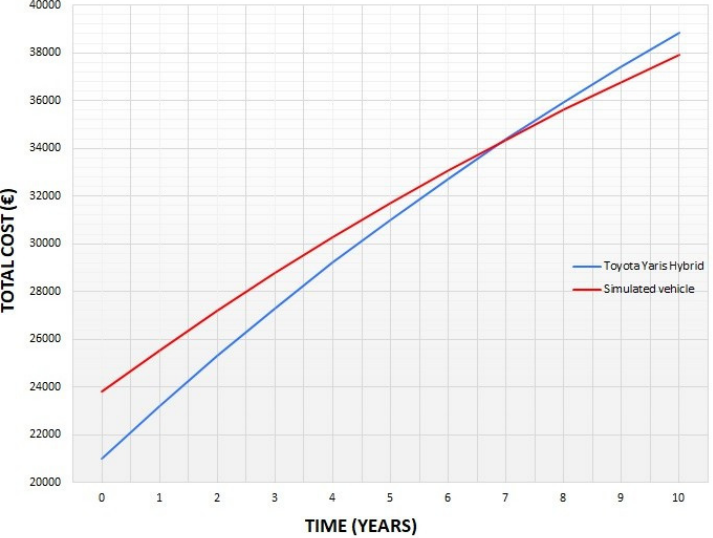
Figure 10. Time history of LCC for the two models examined.